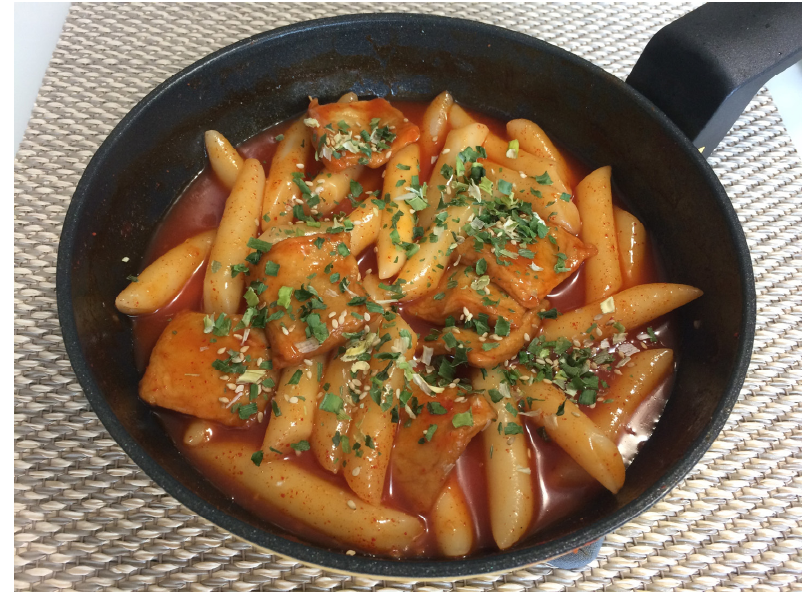
Figure A7. Ingredients: Rice pasta, spring onions, red chili, and condiments (red chili paste, soy sauce, pepper, sesame oil, sesame, sugar, starch syrup); see recipe at: http://www.maangchi.com/recipe/